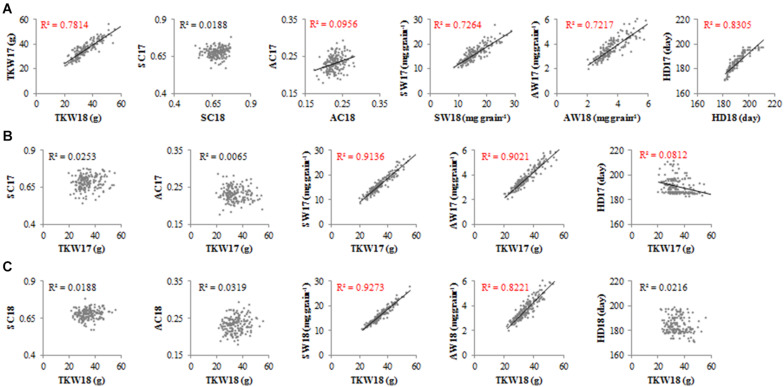
Correlation between traits for all accessions in 2017 and 2018. TKW, thousand kernel weight; SC, starch content; AC, amylose content; SW, starch weight per grain; AW, amylose weight per grain; HD, heading date. (A) Correlation between the same traits in 2017 and 2018. (B) Correlation between TKW and other traits in 2017. (C) Correlation between TKW and other traits in 2018.